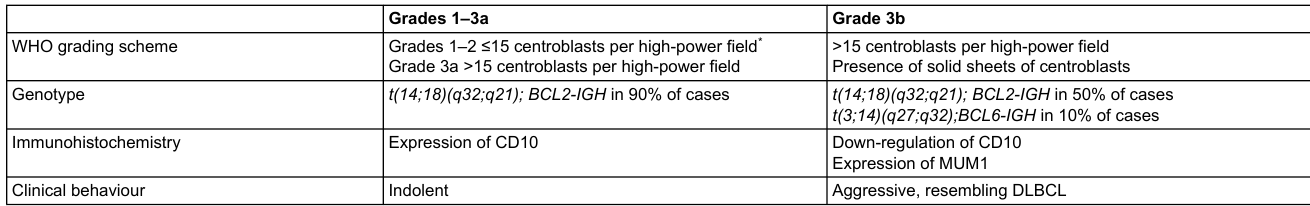
Table 1: Features that distinguish grade 3b follicular lymphoma from grades 1–3a [9,